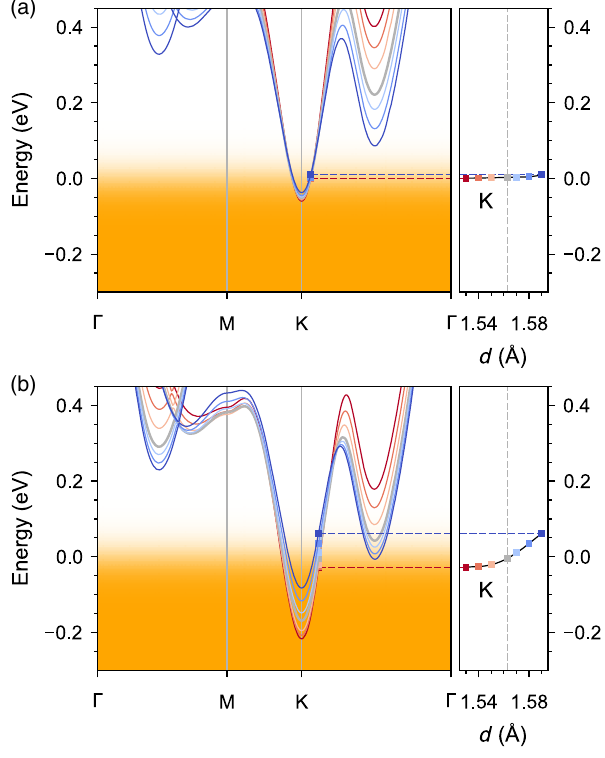
FIG. 9. Variation of the conduction band energies in electron- doped monolayer MoS 2 as a function of the amplitude of the A 1 mode parametrized with the vertical separation d of the plane of chalcogen atoms with respect to the plane of transition metal atoms. The electrochemical potential μ is used as a reference. Electronic states are occupied according to a Fermi-Dirac distribution at 300 K, shown as a color shading (dark yellow corresponding to 1 and white to 0). Two different doping levels are considered: (a) low doping ( n ¼ 0 . 02 e= cell), when only the K valley is occupied, and (b) high doping ( n ¼ 0 . 08 e= cell), when both K and Q valleys are